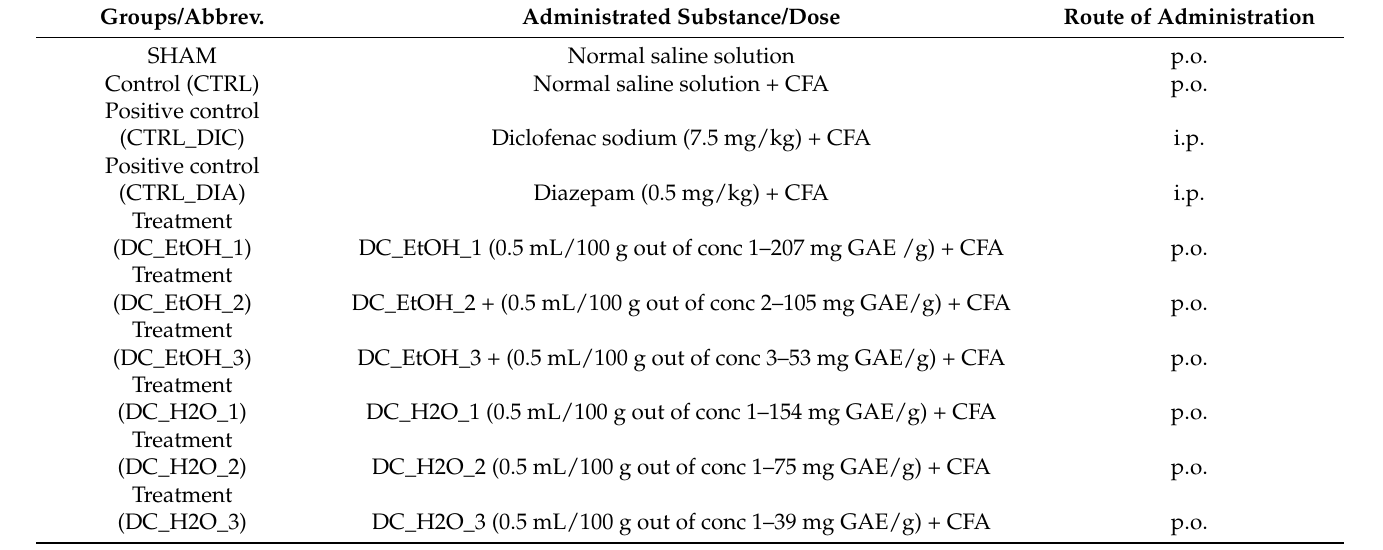
Table 5. Experimental design of CFA-induced chronic